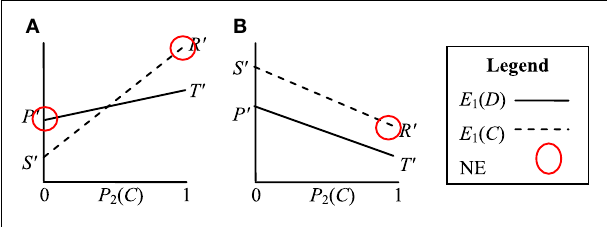
FIGURE 4 | Visualization of the Prisoner’s Dilemma game when perceived by agents with optimally motivating incentives of (A) > R and (B) ½ ( P + S ) > I ∗ > S . The pure strategy Nash ½ ( T + R ) > I ∗ j L Equilibria (NE) are